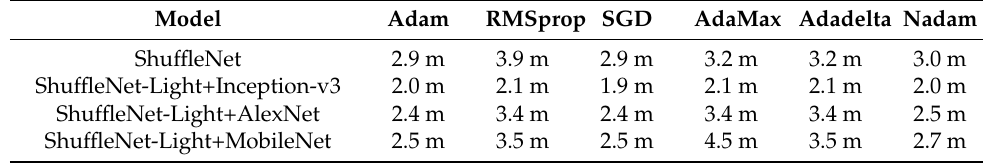
Table 12. Performance of the proposed ShuffleNet-Light model on different